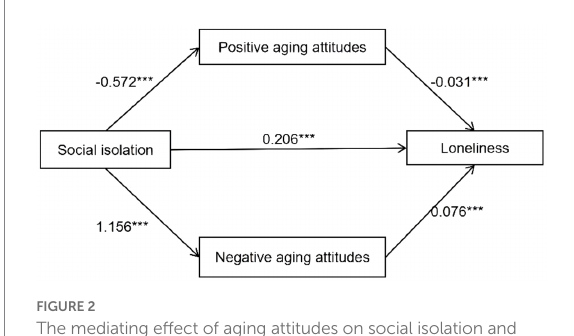
FIGURE 2 The mediating effect of aging attitudes on social isolation and